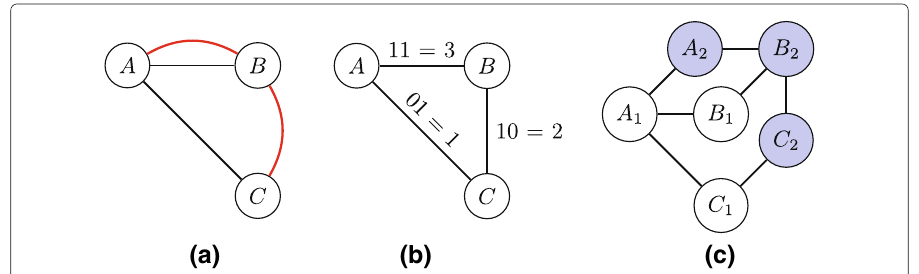
Fig. 4 Multiplex subgraph encoding: from multiplex links to binary labeled (weighted) edges to colored nodes. a Multiplex links, b From binary labels to weighted edges, c Colored nodes